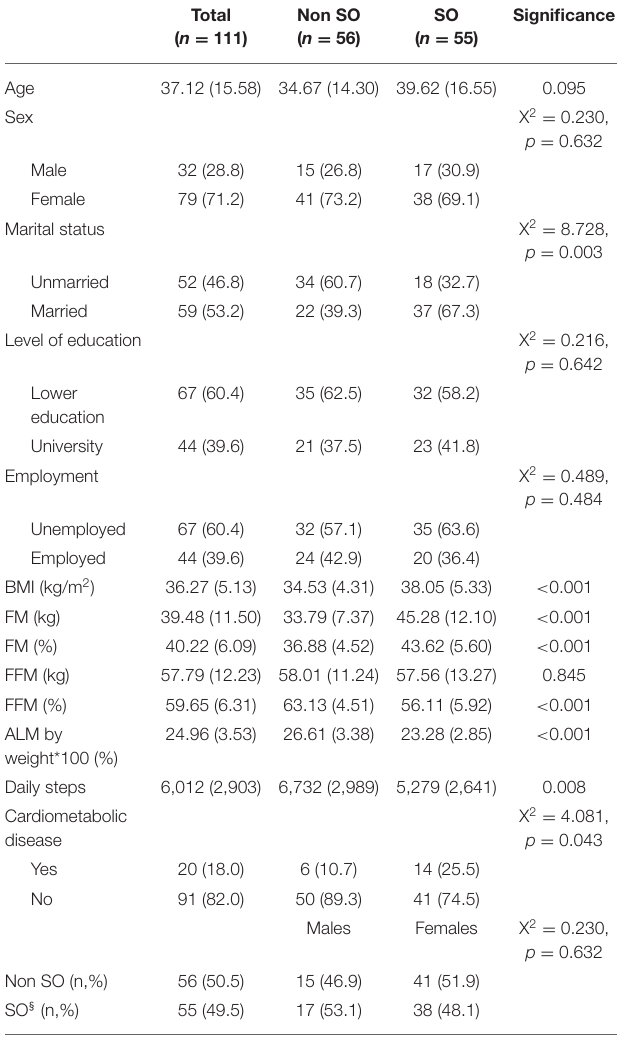
TABLE 1 | Socio-demographic and anthropometric body composition characteristics of the study population ( n =